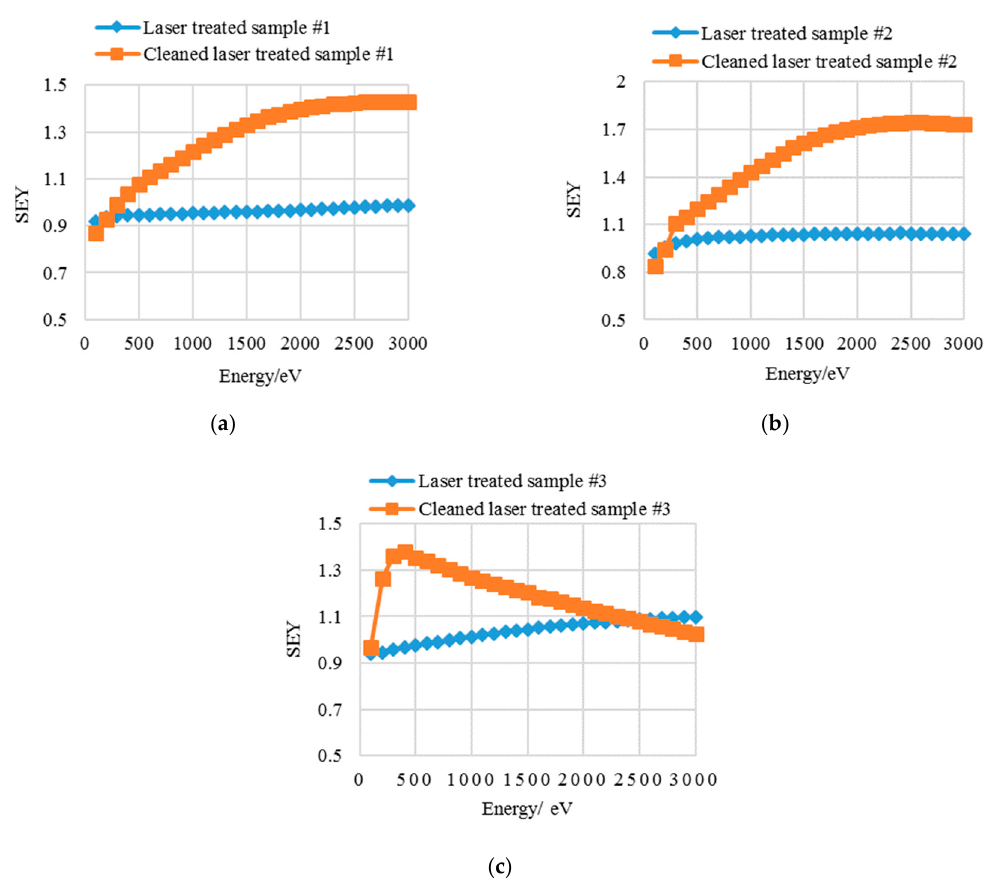
Figure 2. The secondary electron yield (SEY) curves of uncleaned and cleaned laser treated ( a ) samples #1, ( b ) #2, and ( c ) #3.